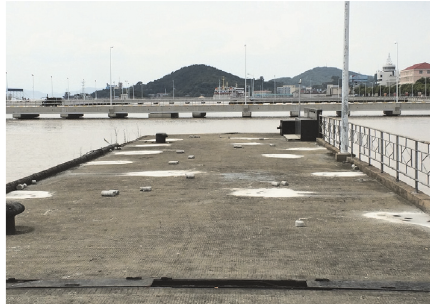
Figure 1: The cores drilling site.